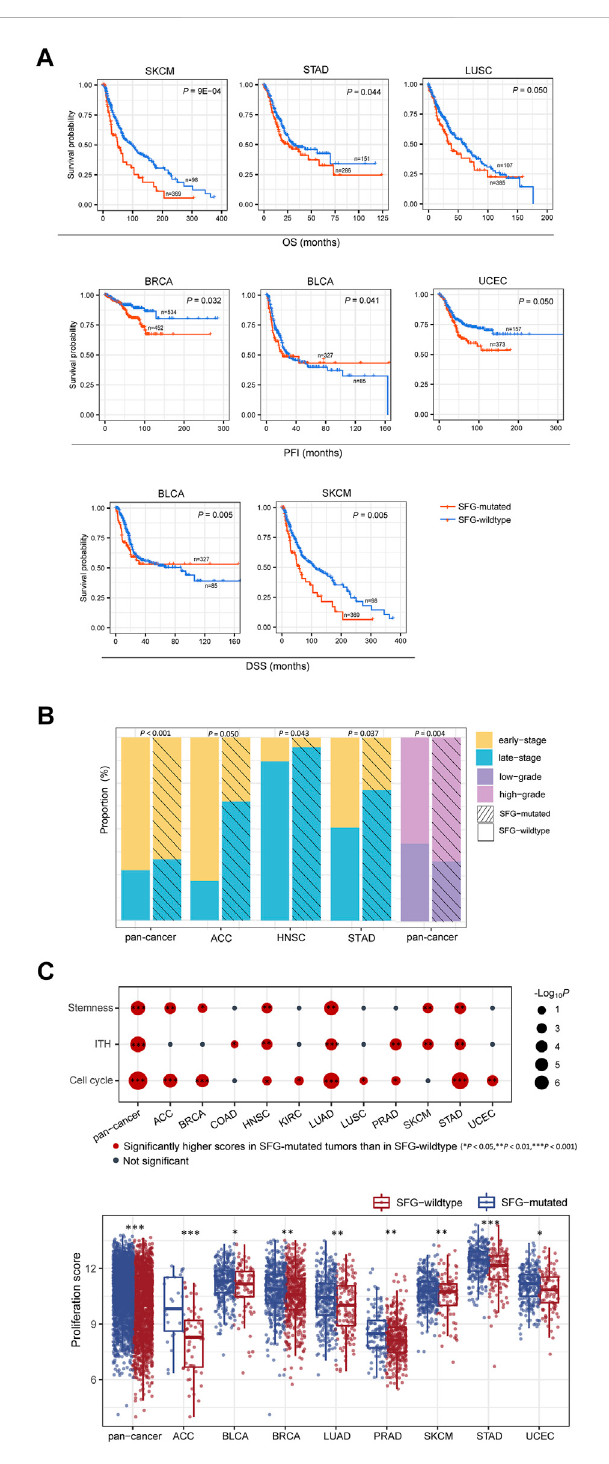
FIGURE 1 SFG mutations correlate with unfavorable clinical outcomes in